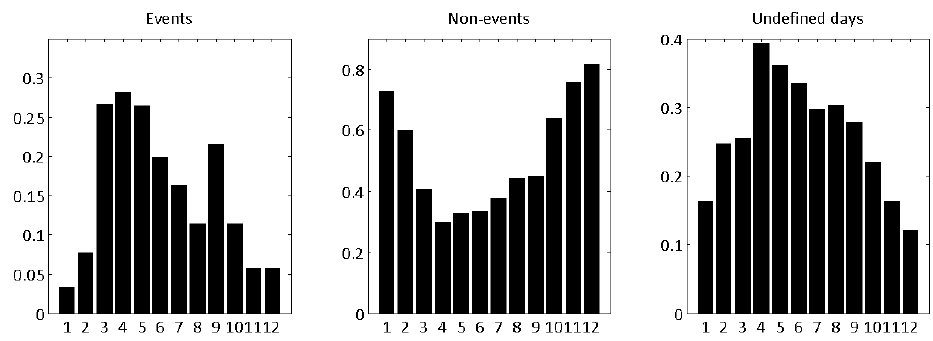
Fig. 2. Mean monthly event, non-event and undefined day fraction 1998–2011. Figure 2 Mean monthly event, non-event and undefined day fraction 1998-2011. 2 Table 1. Monthly mean values (bold) for GR (1992–2011), J 8 (1992–2011) and J 3 (2005–2011). The monthly 25th and 75th percentiles are shown below the means,